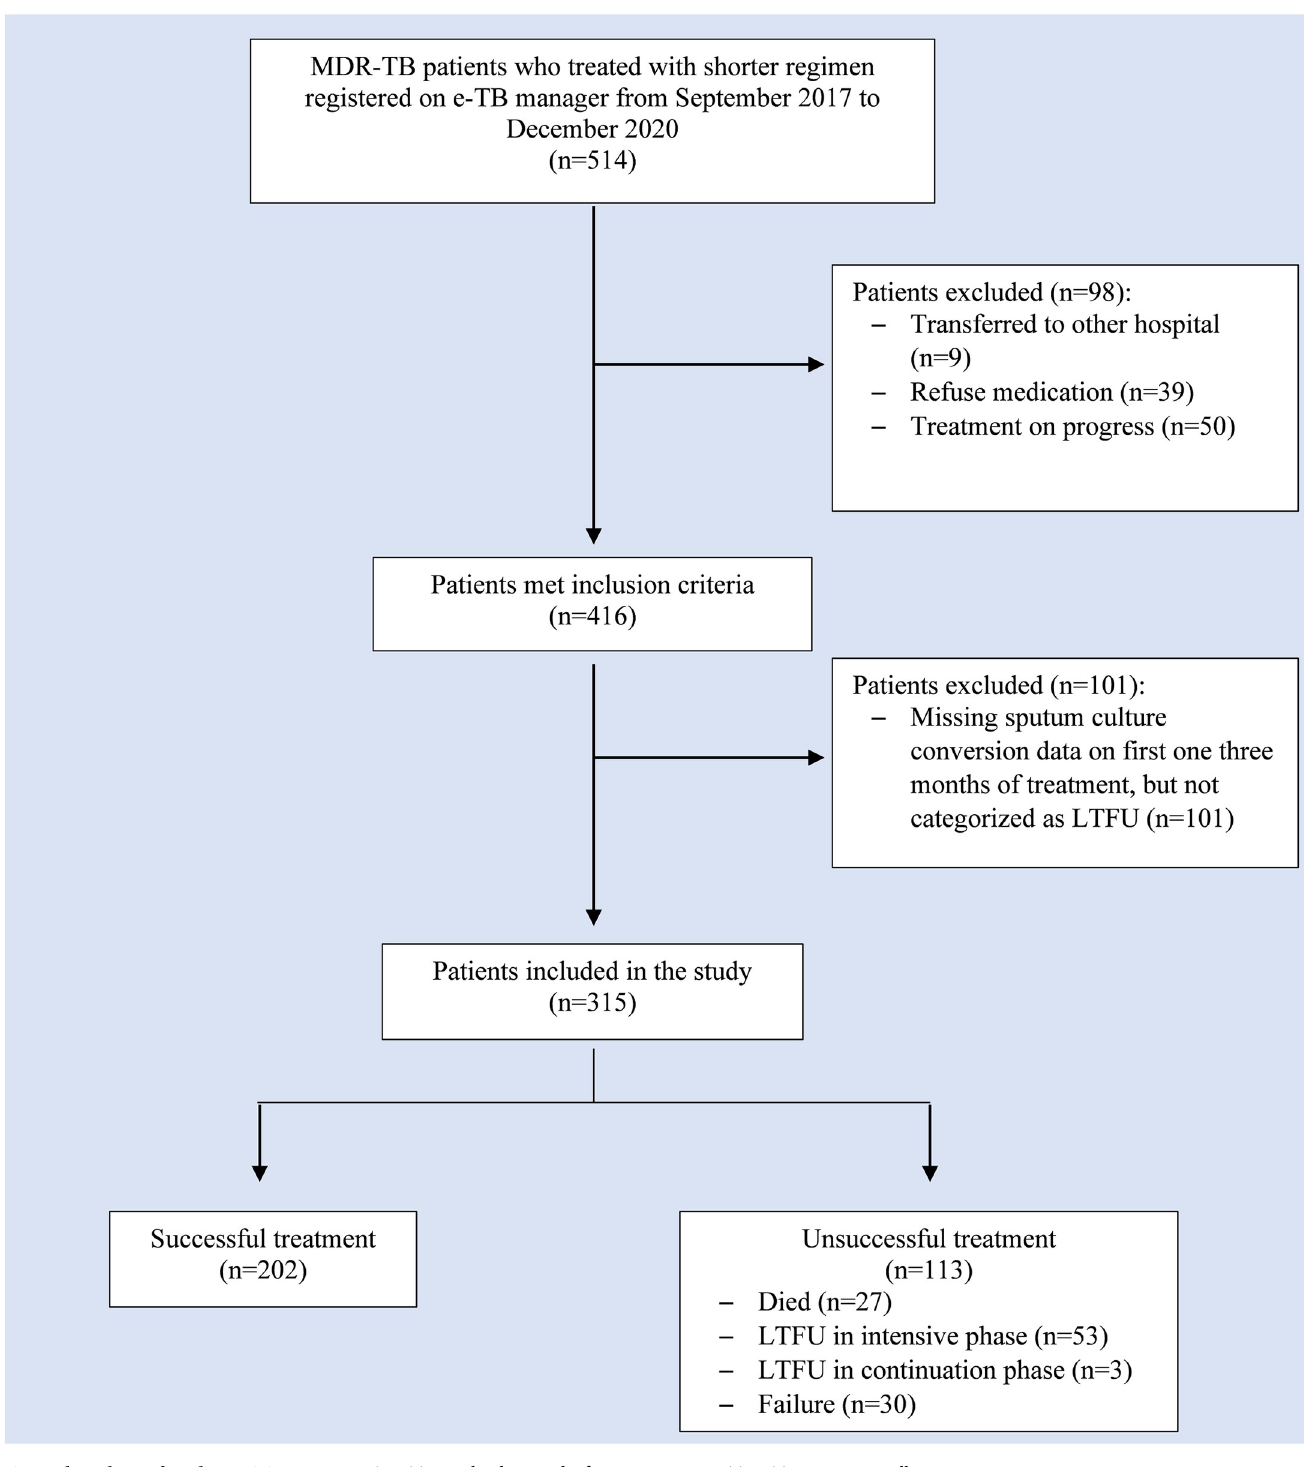
Fig 1. Flow chart of study participants. MDR/RR-TB: Multi-drug and rifampicin resistant TB. LTFU: Loss to Follow Up.